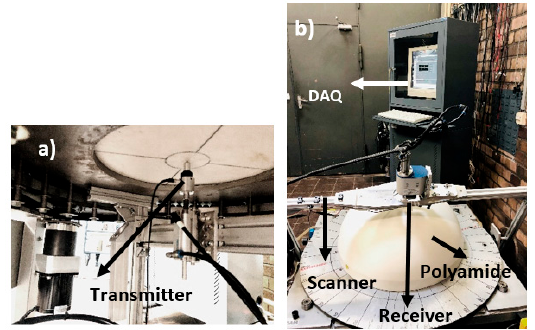
Figure 12. ( a ) Transmitter fixed at bottom flat surface ( b ) Measurement setup.